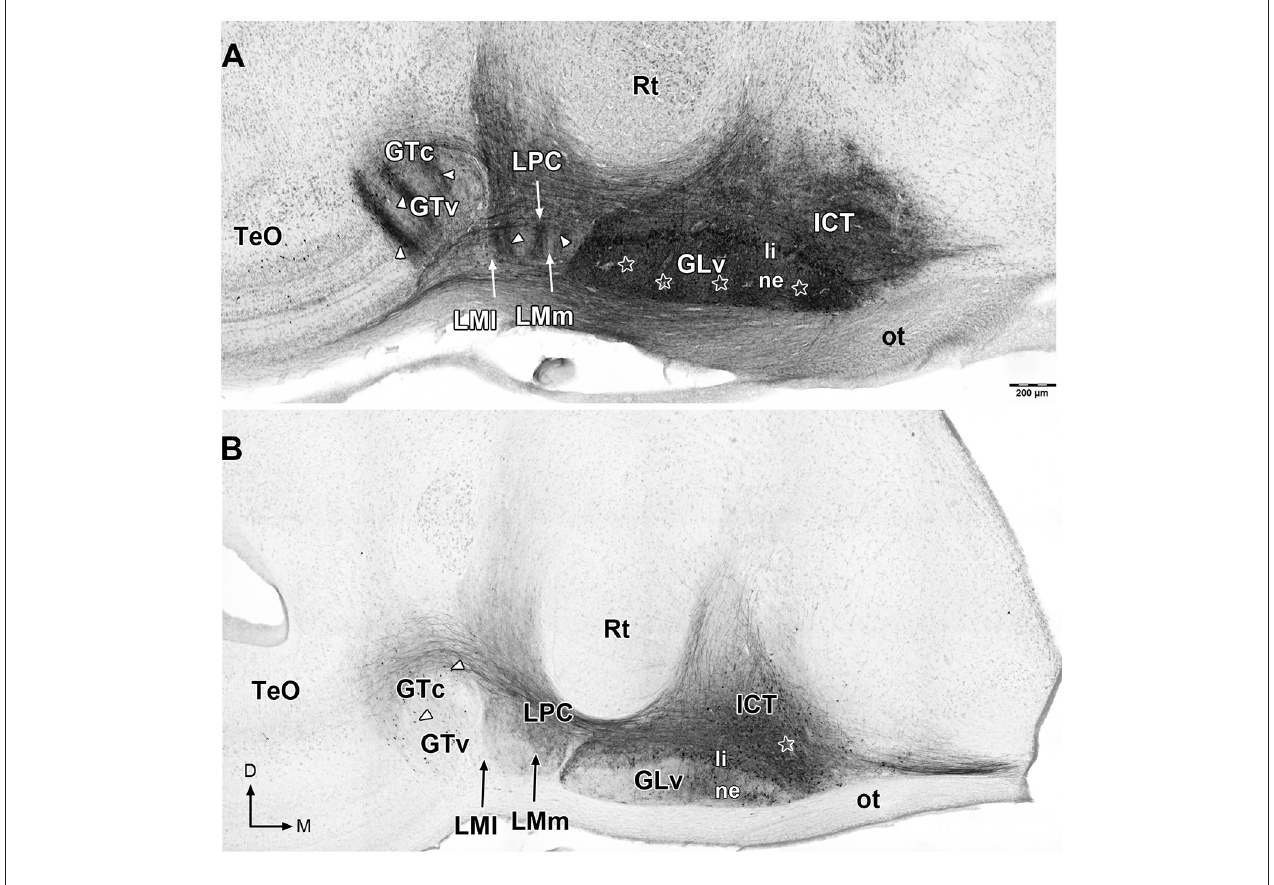
FIGURE 2 | Giemsa counterstaining of 60 µ m sections that shows retrograde and anterograde labeling of neurons and processes (white arrowheads) in the ventral thalamus and pretectum after in vitro injections in the GLv-ne (A) and ICT (B) (white stars). Note in (A) the clear topographic pattern in the LM and GT, and the massive non-topographic labeling in the ICT after GLv-ne injections. D, dorsal; M, medial. Orientation in (B) applies to (A)